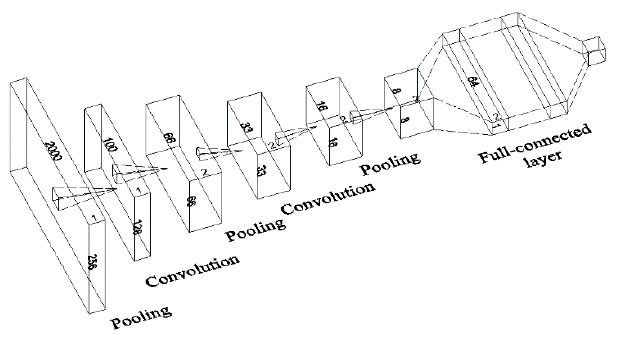
Figure 5. The structure of the CNN. Table 1. CNN